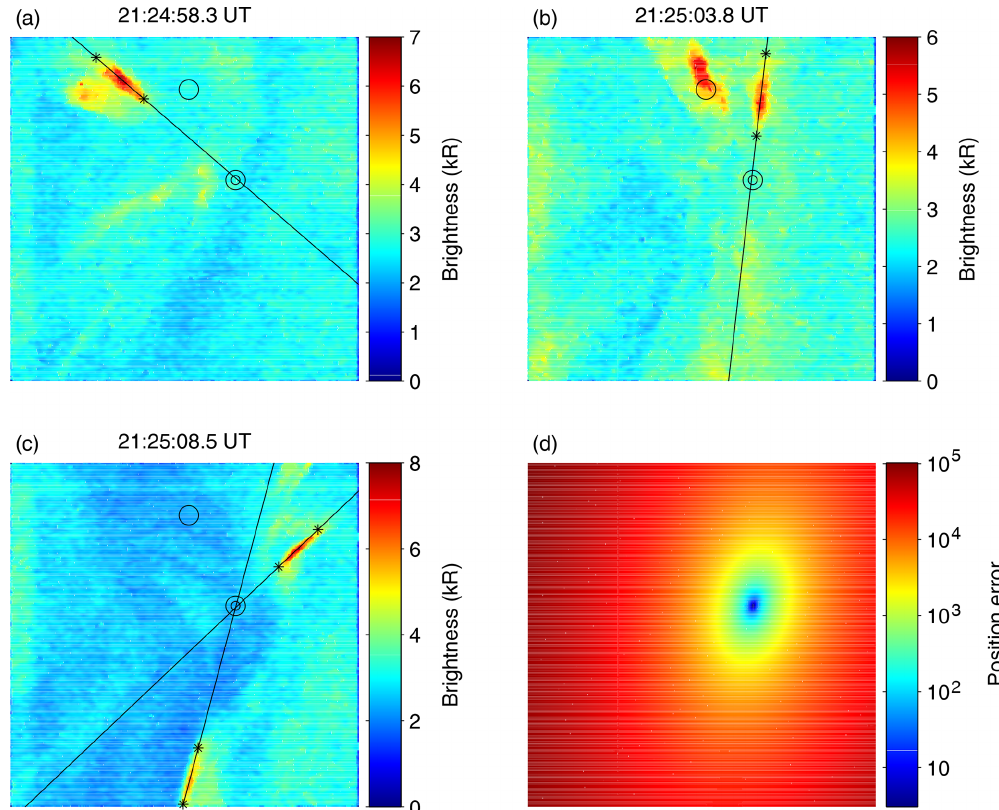
Figure 2. (a–c) Images of the auroral brightness observed by ASK1 (673.0nm). The black lines pass through rayed structures; the asterisks indicate the region of the line drawn manually. The single circle in each image is the position of the IGRF estimate of the magnetic field. The double circles mark the estimate of the zenith position from the four rays. (d) The sum of the squares of the distances between a given pixel and each ray